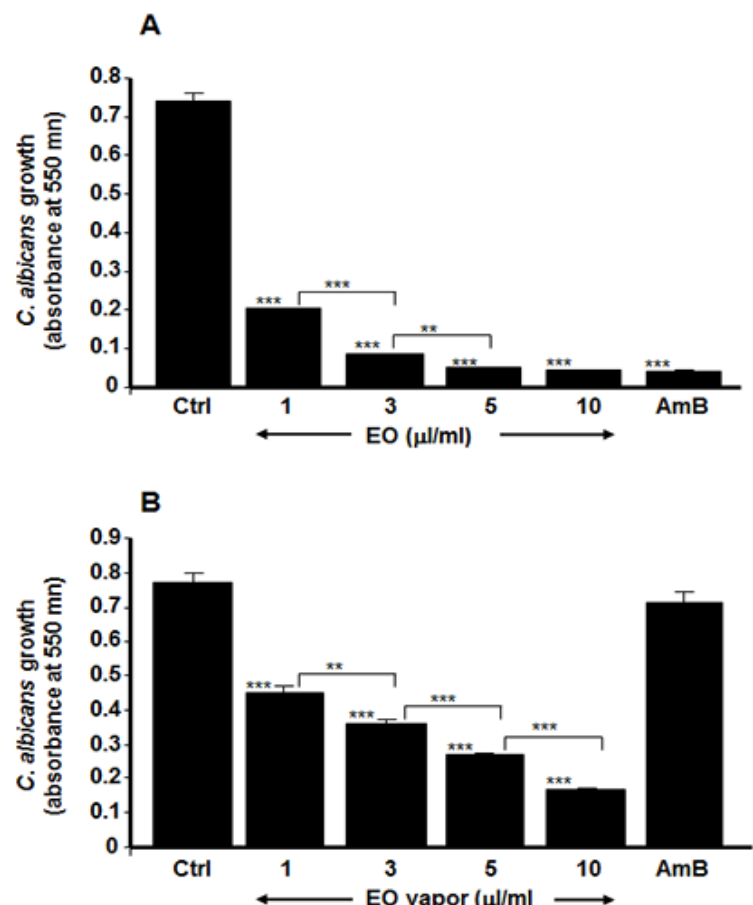
Figure 1. Mentha × piperita essential oil inhibited C. albicans growth. The yeast was cultured in Sabouraud supplemented medium with and without Mentha × piperita EO at various concentrations. The cultures were maintained for 24 h at 37 ◦ C and an MTT assay was performed. The growth was plotted as the means ± SD of the absorbance at 550 nm. ( A ) C. albicans growth in the presence of whole EO added to the culture medium; ( B ) C. albicans growth in the presence of EO vapor suspended 4 cm away from the culture surface. The levels of significance for C. albicans growth in the presence or absence of EO or AmB (5 µ g/mL) were calculated; *** p < 0.001, ** p < 0.01. The free asterisks refer to the statistical difference when comparing EO effects to control. The bars with asterisks showed the comparison of the different concentrations of